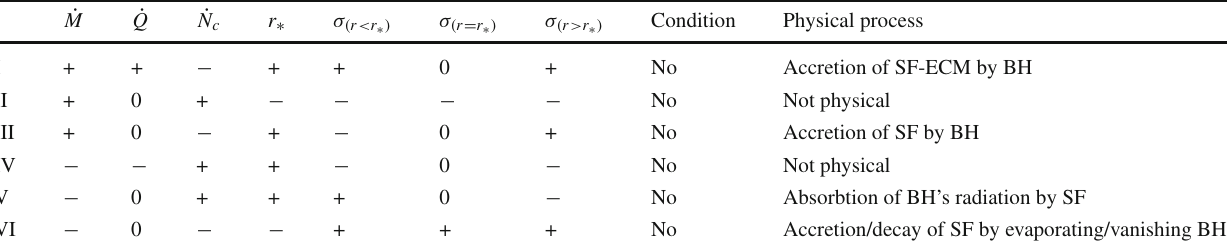
Table 7 General Bonnor–Vaidya BH and its cosmological SF parameters for (cid:2) = − 1